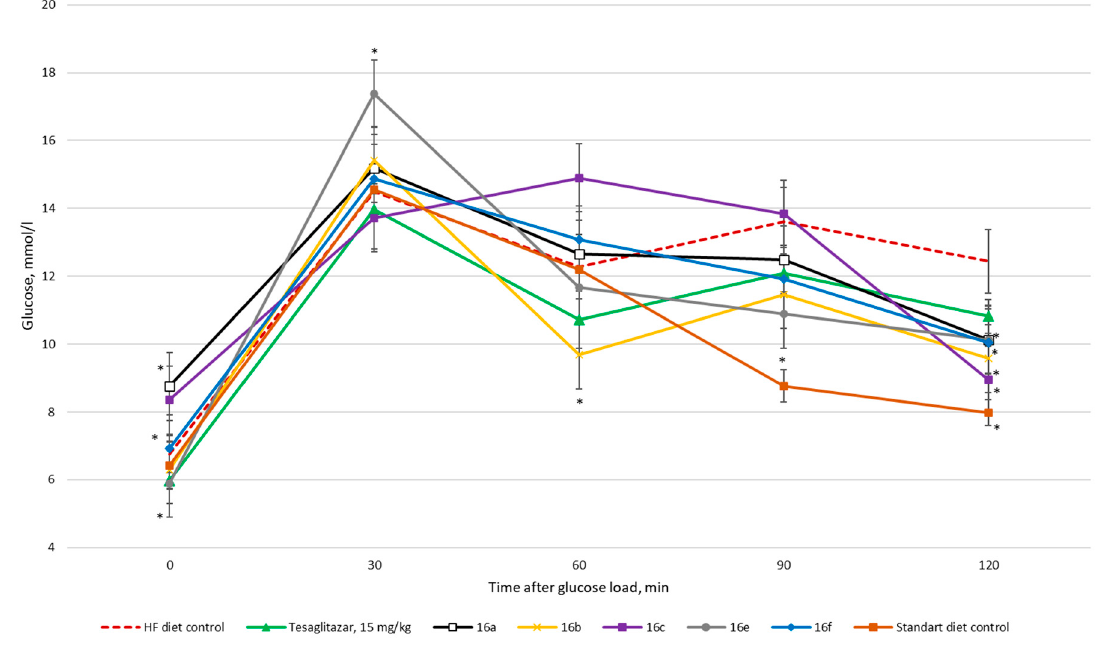
Figure 4. Oral glucose tolerance test results. 16a–f were introduced at a dose of 30 mg/kg. * p < 0.05 compare to HF diet control.